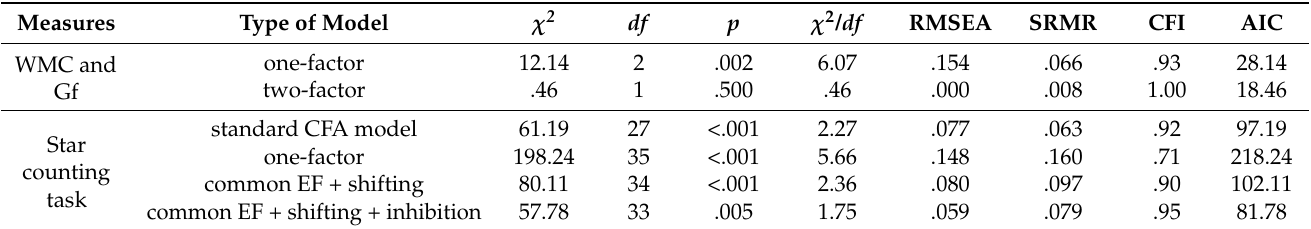
Table 2. Fit statistics of the measurement models for working memory capacity, fluid intelligence, and executive processes based on the star counting task. WMC, working memory capacity; Gf, fluid intelligence; EF, executive function; AIC, Akaike’s information criterion.